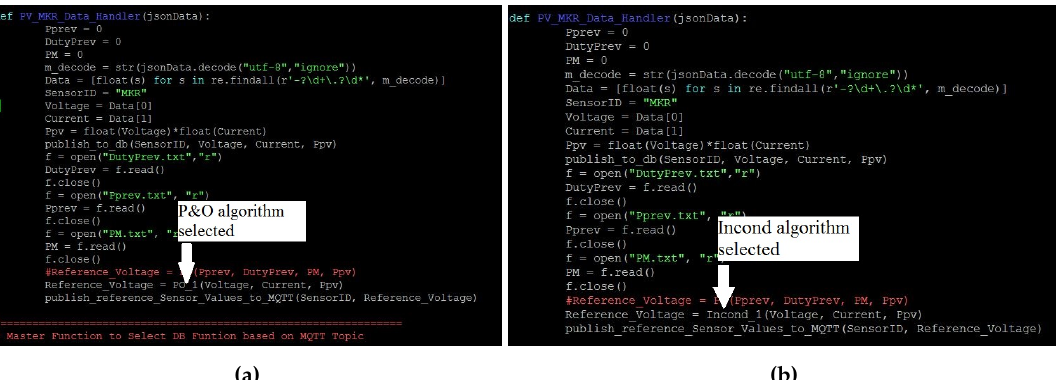
Figure 6. The MPPT algorithm selection. ( a ) P&O; ( b ) InCond.